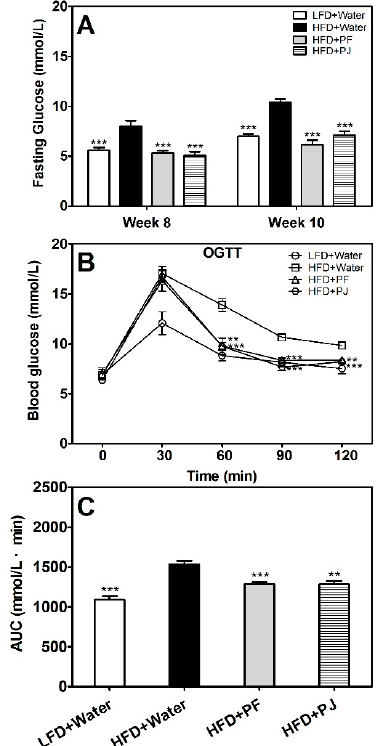
Figure 4. Effects of PF and PJ extracts on fasting glucose ( A ); oral glucose tolerance test (OGTT) ( B ); and area under curve (AUC) ( C ) in HFD C57BL/6 mice. Data are presented as mean ± SEM ( n = 6–10). ** p < 0.01, *** p < 0.001, compared to the HFD group treated with water.